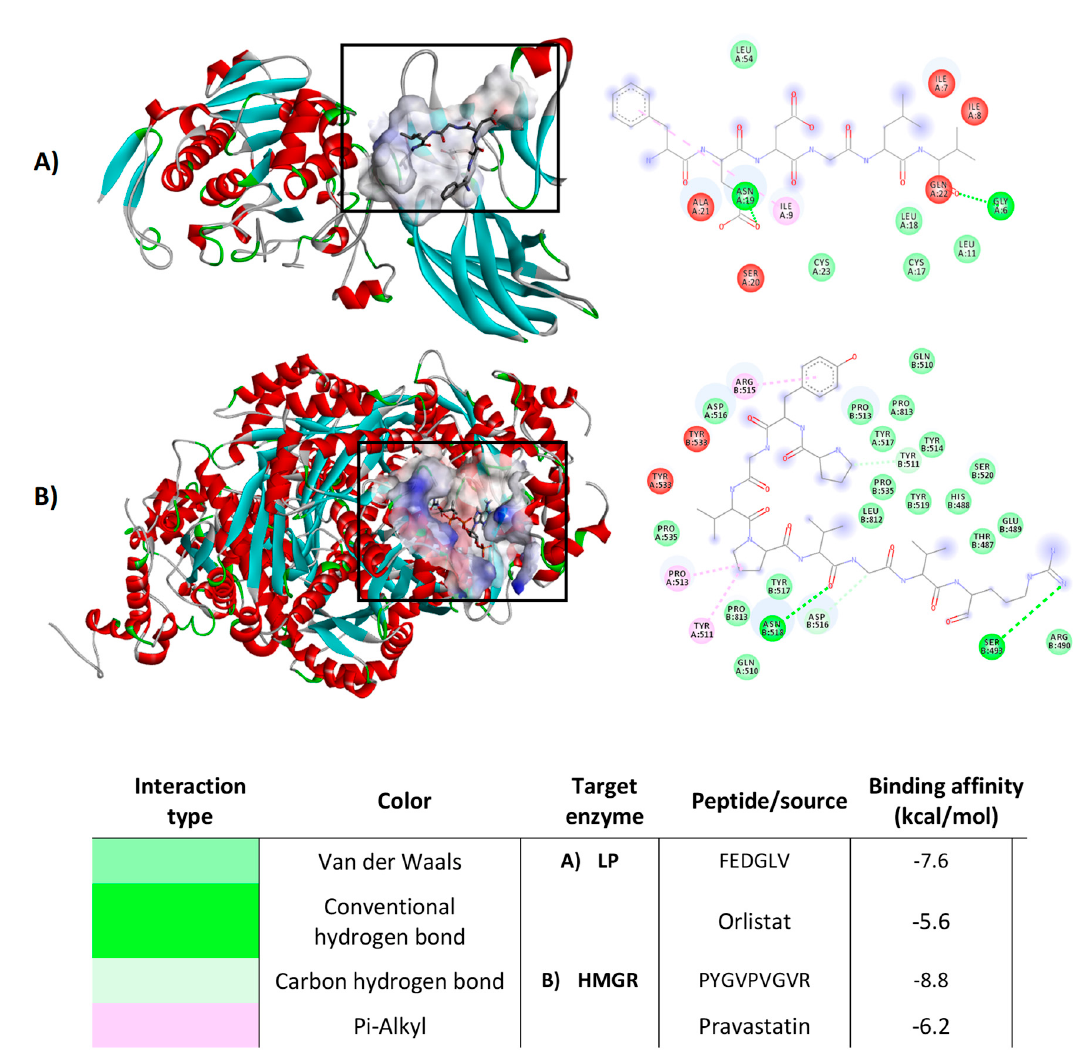
Figure 6. Molecular docking diagrams, examples of the best pose of the most potent legume peptides in the catalytic site of pancreatic lipase ( A ) and HMGR ( B ). Results represent the mean ± SD of at least two independent experiments.